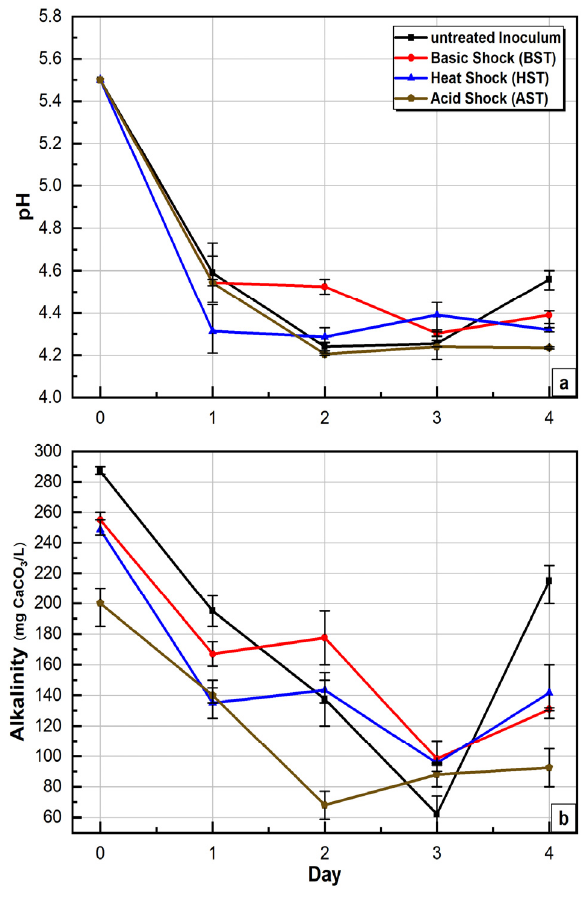
Figure 6. The behaviour curve of ( a ) pH and ( b ) alkalinity during 5-day BHP tests (average value of triplicate with max/min bar).